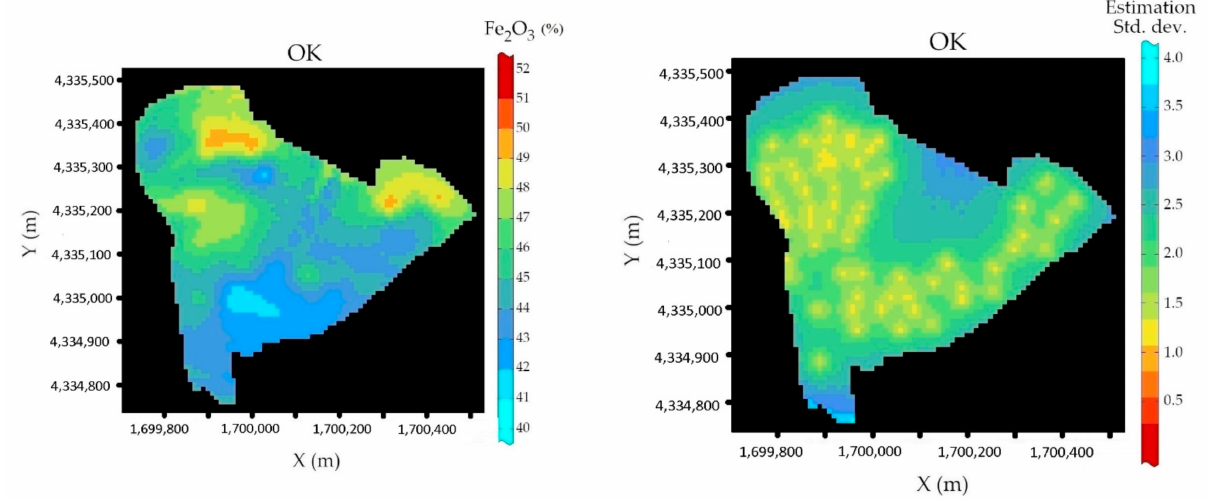
Figure 6. Fe 2 O 3 (%) estimated map ( OK ) ( left ) and the estimation variance map ( right ) by performing OK . To perform co-kriging, the sample variograms and variogram models considering both variables (iron as main variable and ferrous iron oxides band ratio as the secondary variable) and cross variogram are calculated and shown in Figure 7. The fitted model for iron concentration is equal to the model used in OK . Using the same model makes the comparisons more logical between the OK and CK . The structure and model details are presented in Table 3.